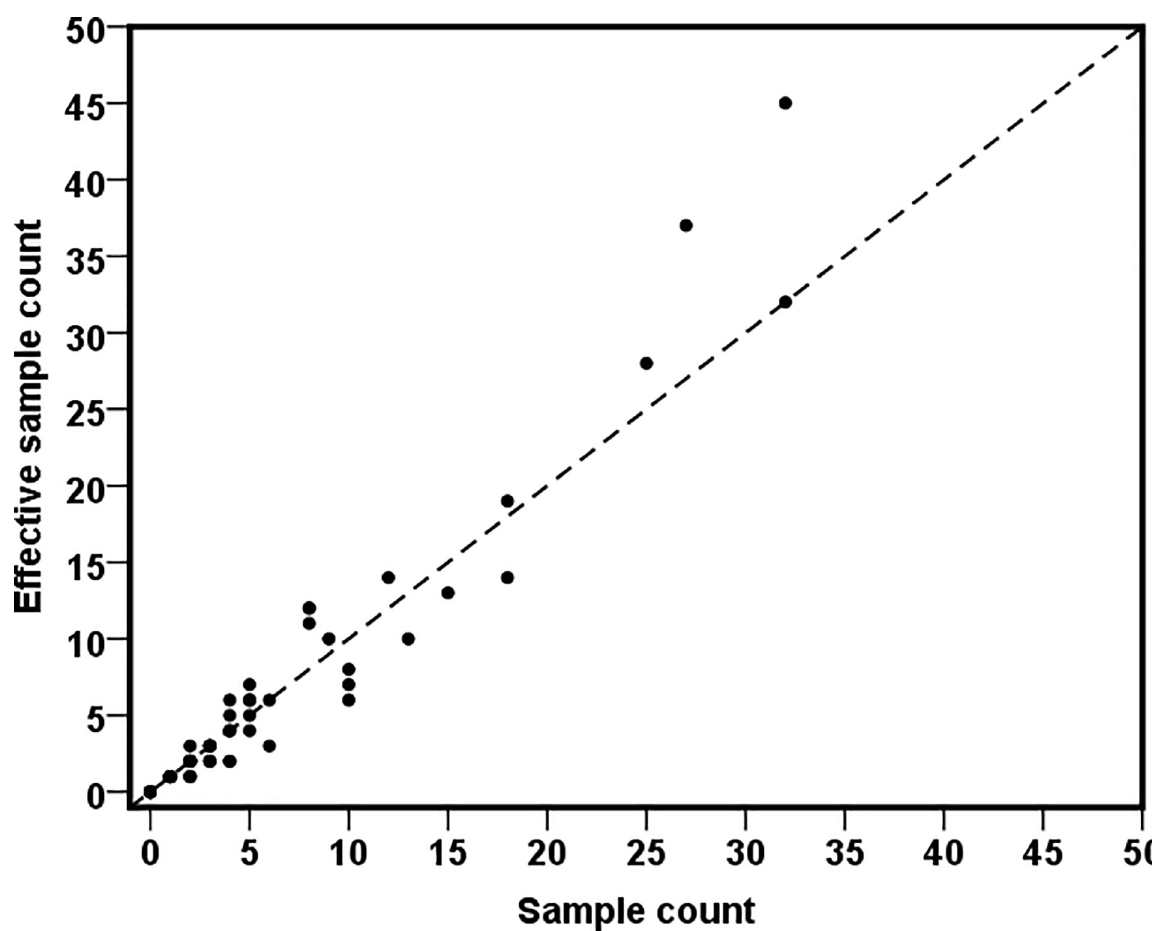
Fig 4. District-wise effective sample count vs observed sample count in BDHS 2014 data.